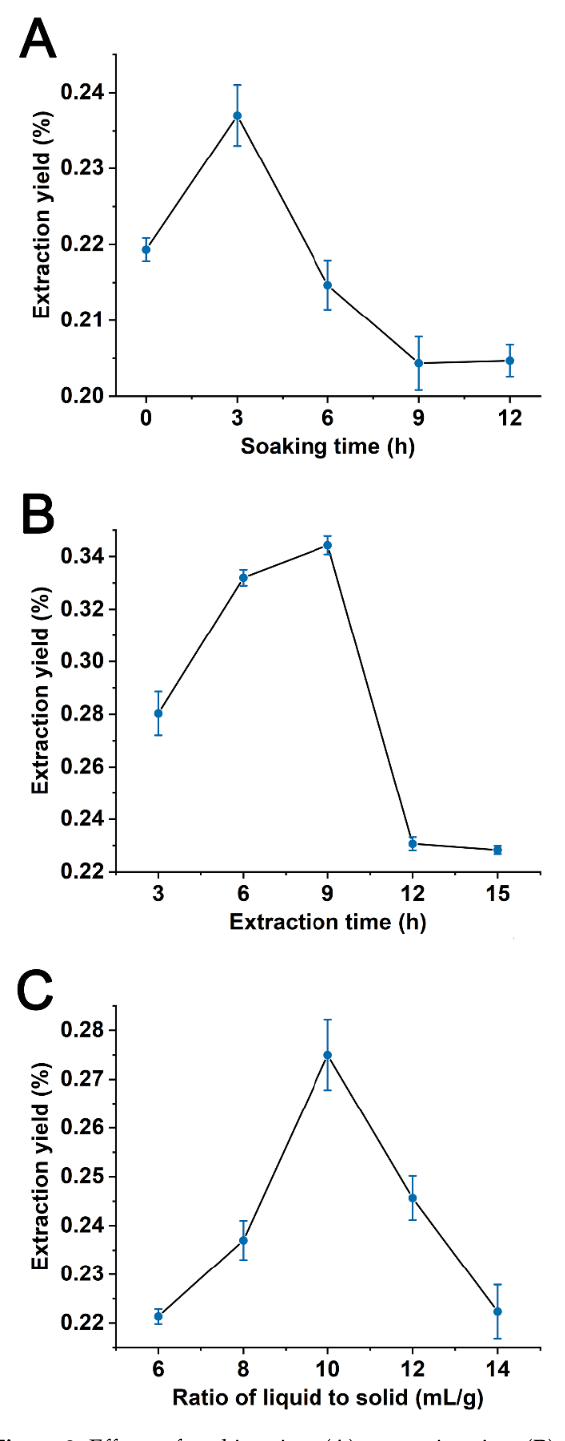
Figure 2. Effects of soaking time ( A ), extraction time ( B ) and liquid to solid ratio ( C ) on extraction yield of Polygonum orientale essential oil (%).